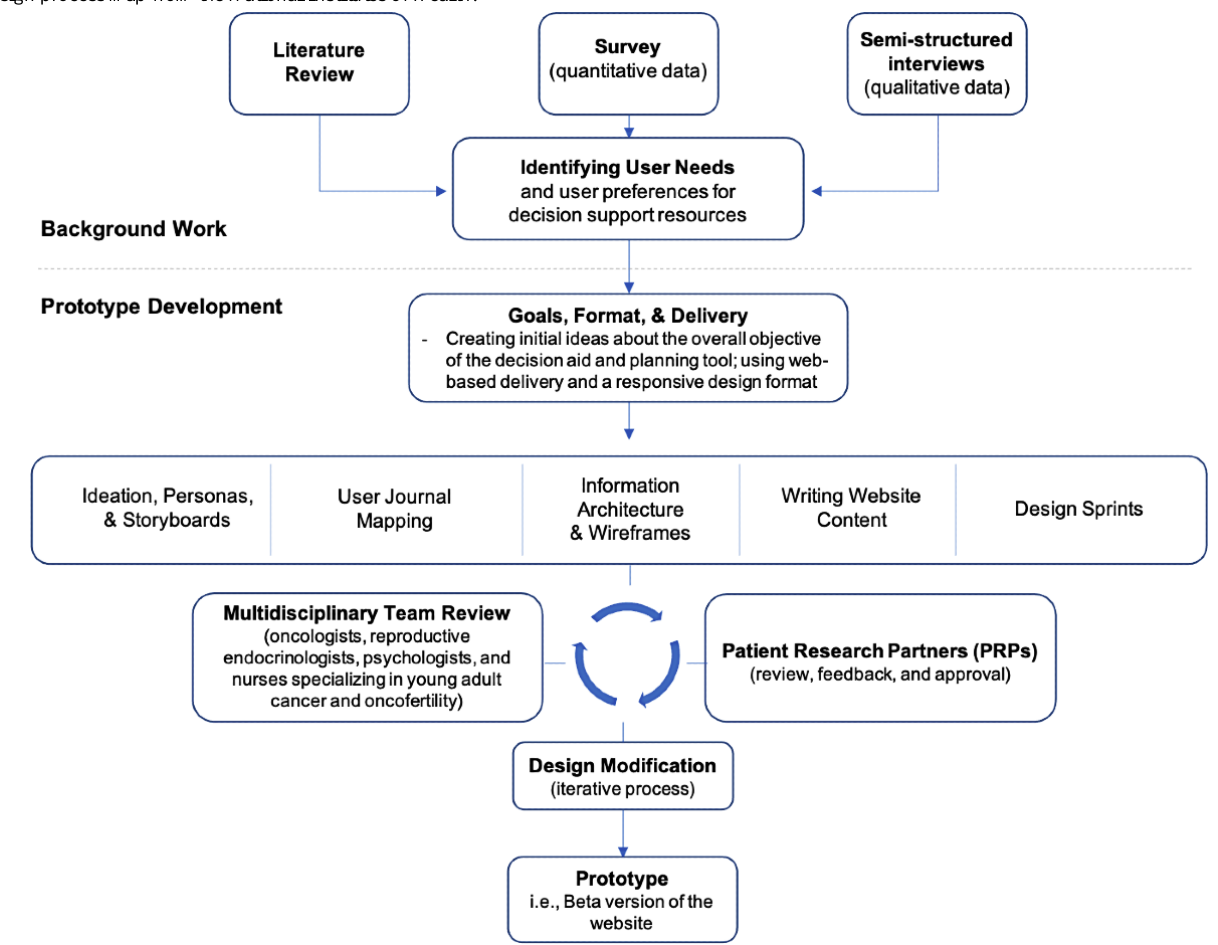
Figure 1. Steps taken to develop a patient decision aid and planning tool prototype using user-centered design strategies. Adapted from the user-centered design process map from the National Institutes of